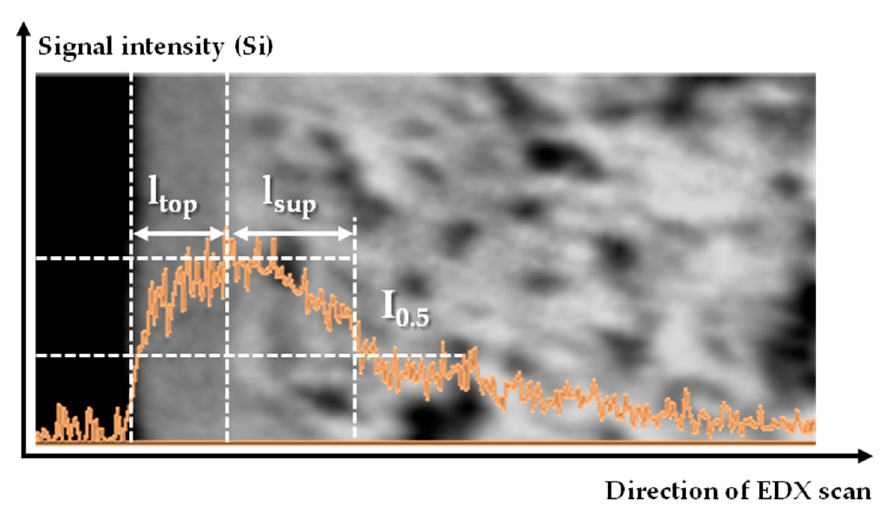
Figure 6. Estimation of PTMSP penetration depth into the pores of the support (l sup ).